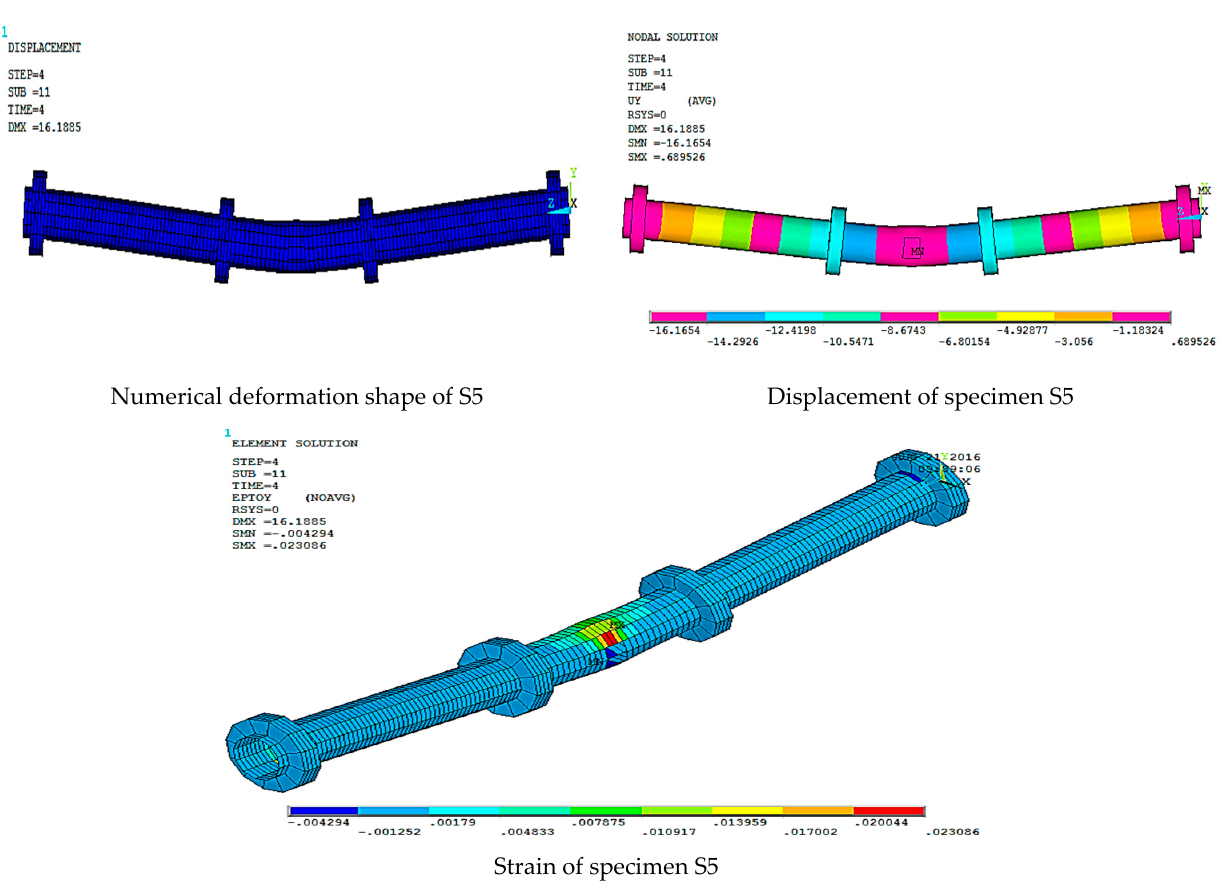
Figure 20. Numerical analysis of S5.